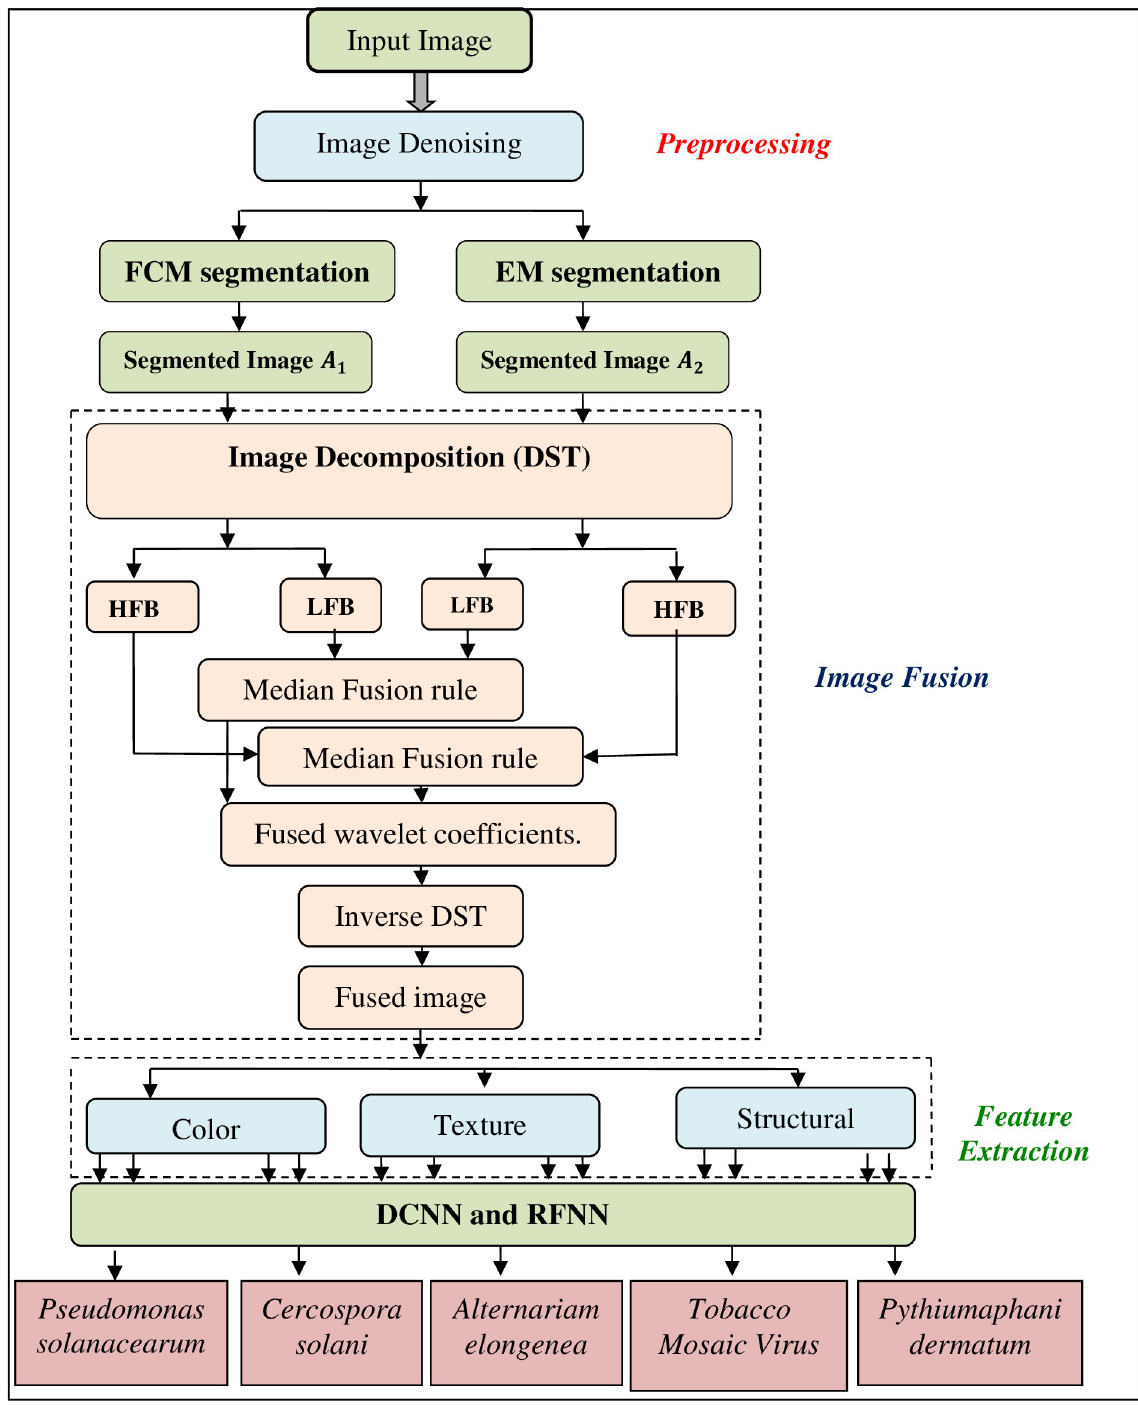
Fig 2. The proposed methodology to diagnose the brinjal leaf diseases.